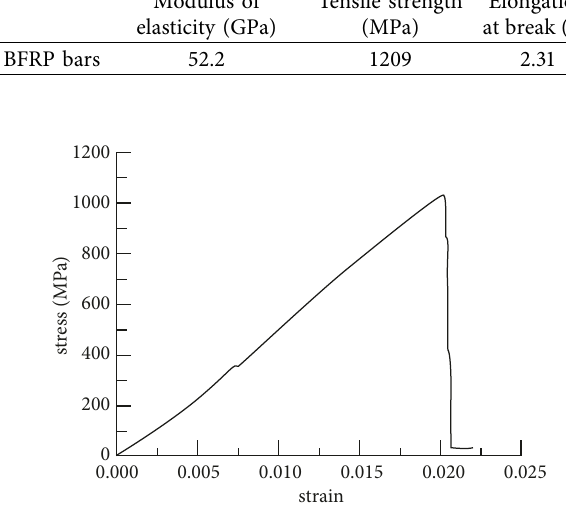
Table 1: Physical and mechanical properties of BFRP bars. Modulus of elasticity (GPa)